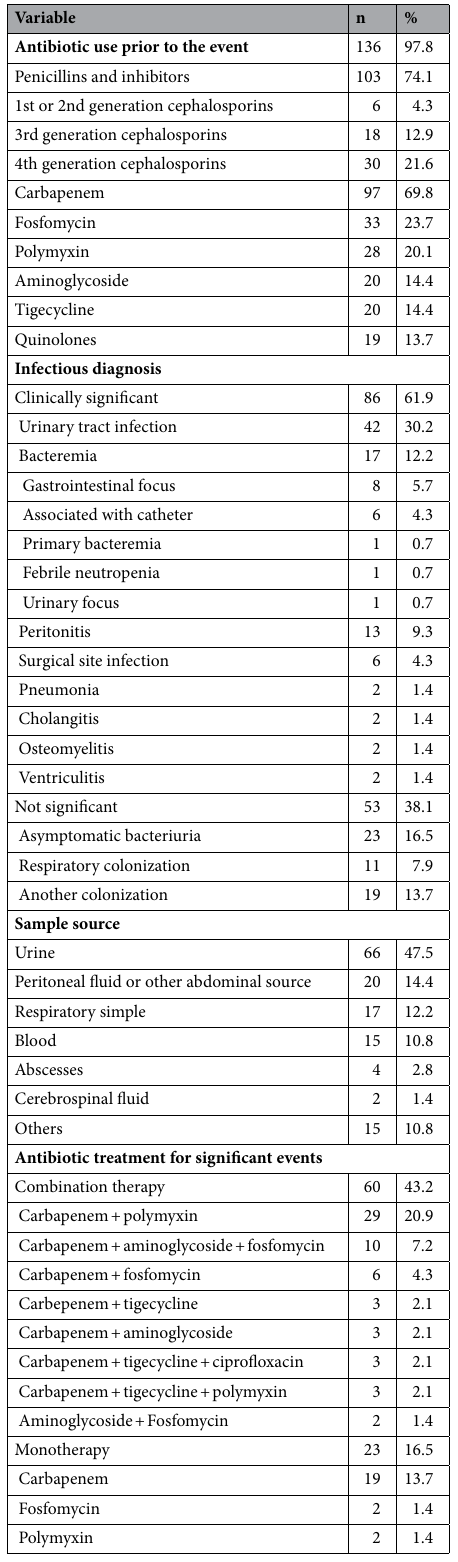
Table 2. Clinical and microbiological information of the events in which KPC- Kp isolates were